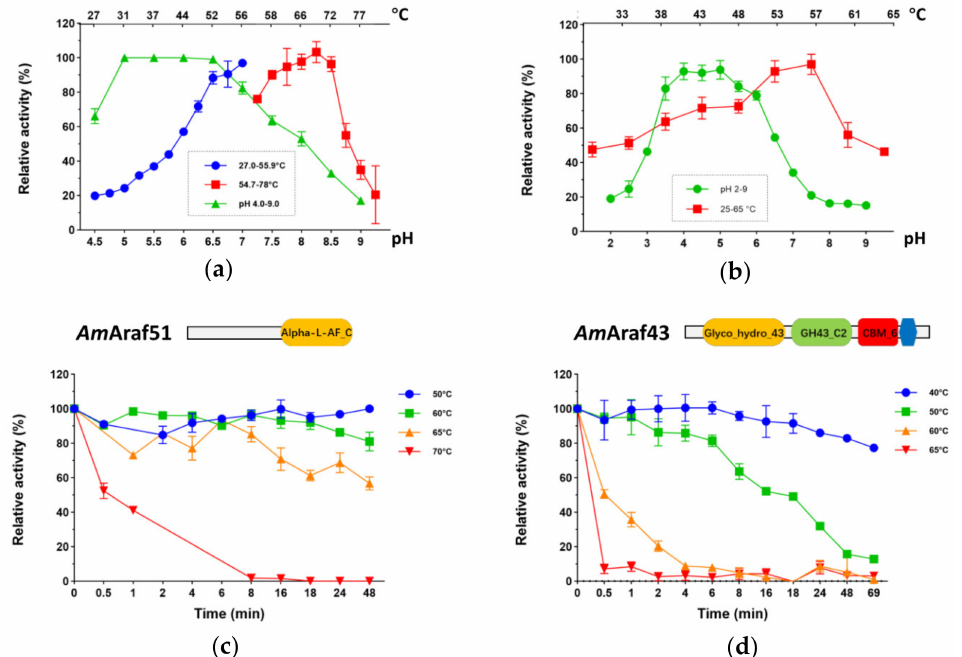
Figure 4. Temperature and pH dependence of Am Araf51 ( a ) and Am Araf43 ( b ), and thermoinactiva- tion kinetics of Am Araf51 ( c ) and Am Araf43 ( d ). Relative activities were calculated from p NP-AF assay standard reactions (2 mM p NP-AF and 25 mM citrate phosphate buffer 20 min) with 6.2 nM Am Araf51 or 2.4 µ M Am Araf43. The maximal activity was set as 100%. Error bars represent standard deviations ( n =